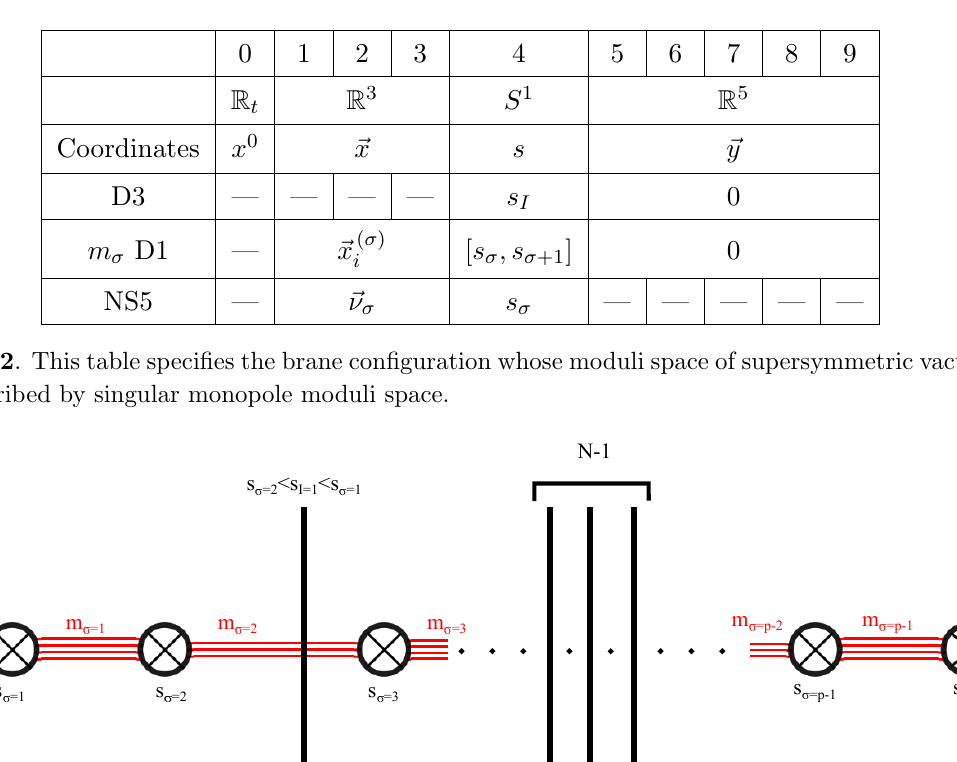
(cid:15) The Higgs vevs for the U( m